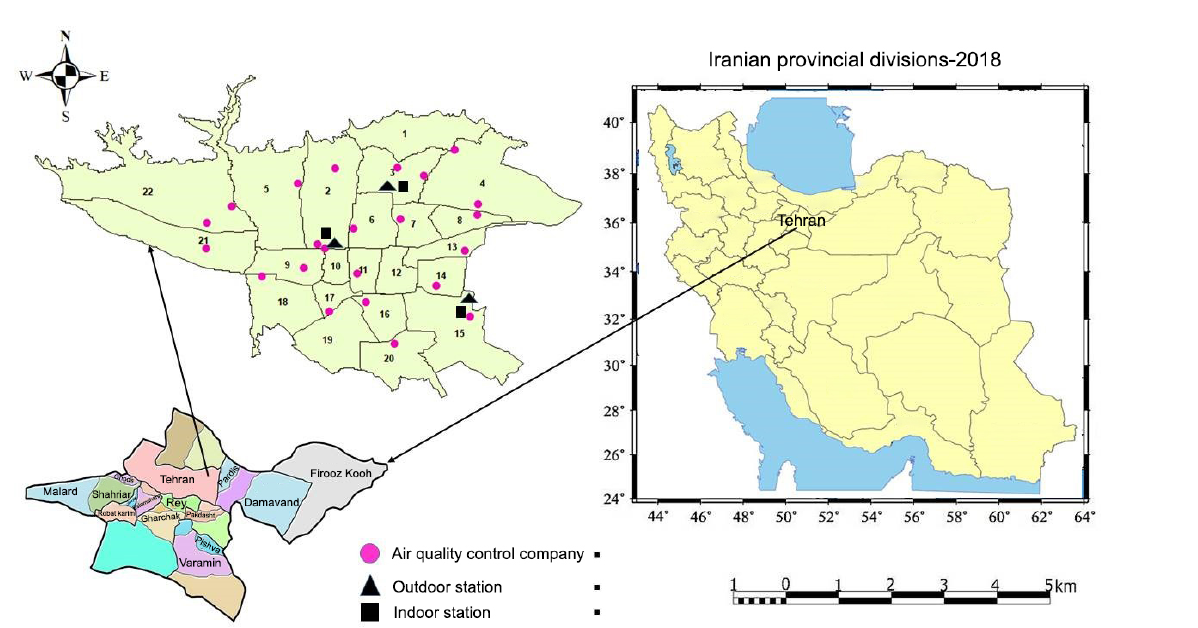
Figure 1. Geographical location of the study area and research sampling stations in Tehran metropolis